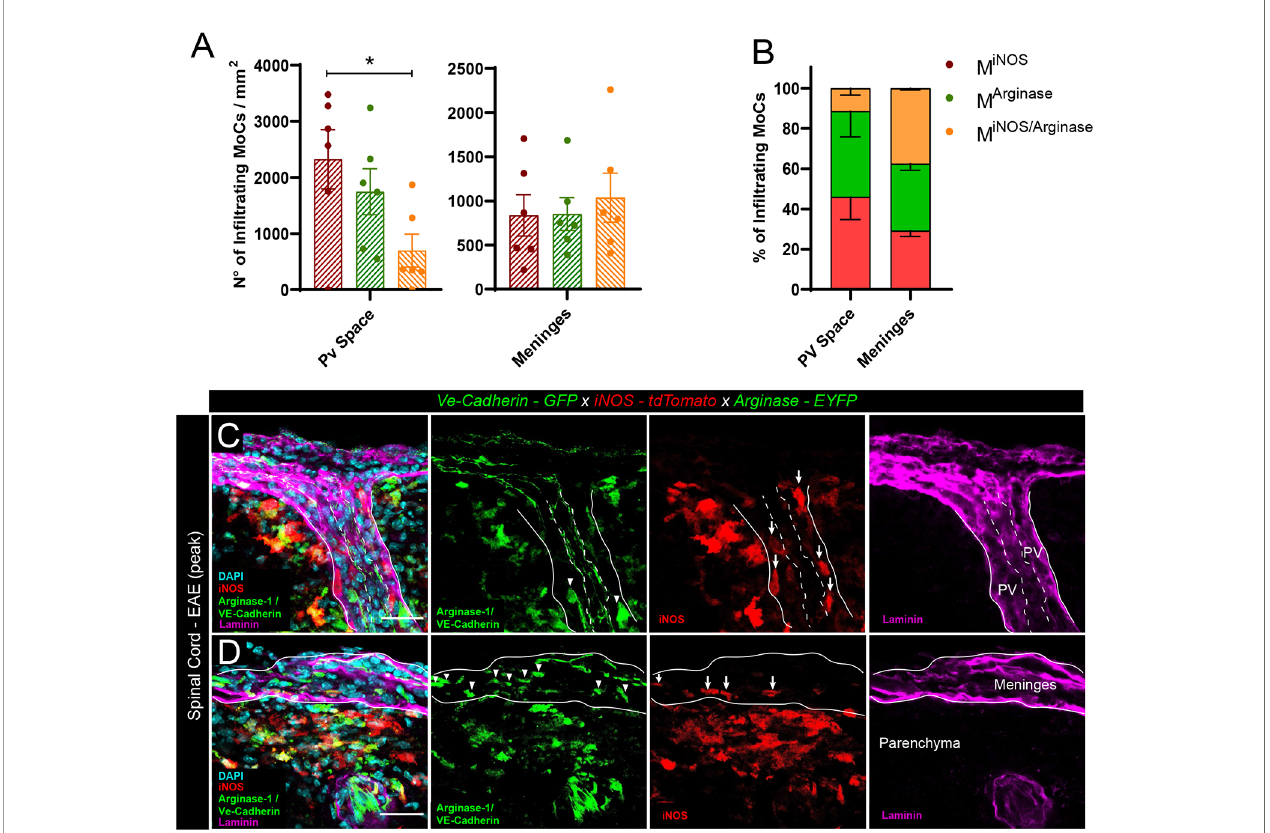
FIGURE 1 | Polarized MoC density in perivascular and leptomeningeal spaces during EAE. (A) Density of M iNOS , M Arginase and M iNOS/Arginase cells in the perivascular spaces and leptomeninges of VE-cadherin-GFP x iNOS-tdTomato x Arginase-EYFP mice induced with EAE (6 mice at day 3 after onset of the disease). Data represented as mean ± SEM. Statistical analysis performed by one-way ANOVA with Tukey ’ s multiple comparisons test, p=0.0389, *p < 0.05. (B) Relative percentage of the M iNOS , M Arginase and M iNOS/Arginase cells shown in (A) . Within perivascular spaces, a higher percentage of M iNOS cells are detected (Mean = 46.09%, SEM = 11.34) as compared to M Arginase (Mean = 42.47%, SEM = 12.80) and M iNOS/Arginase (Mean = 11.44%, SEM = 3.46). In contrast, within the meninges, a predominant population of M Arginase (Mean = 33.24%, SEM = 3.23) and M iNOS/Arginase (Mean = 37.49%, SEM = 0.97) was found, as compared to M iNOS (Mean = 29.27%, SEM = 2.91). No statistically signi fi cant differences were observed, one-way ANOVA with Tukey´s multiple comparisons test. (C, D) Representative confocal images of spinal cord perivascular spaces (C) and leptomeninges (D) of VE-cadherin-GFP x iNOS-tdTomato x Arginase-EYFP mice induced with EAE (3 days after disease onset). tdTomato indicates M iNOS , EYFP/GFP M Arginase cells and VE-cadherin of endothelial cell junctions. Staining with DAPI reveals nuclei, immunostaining with anti-laminin antibody reveals the perivascular and meningeal extracellular matrix. Arrowheads highlight M Arginase cells and arrows indicate M iNOS cells in the perivascular space (C) and meninges (D) . Scale bar, 30 m